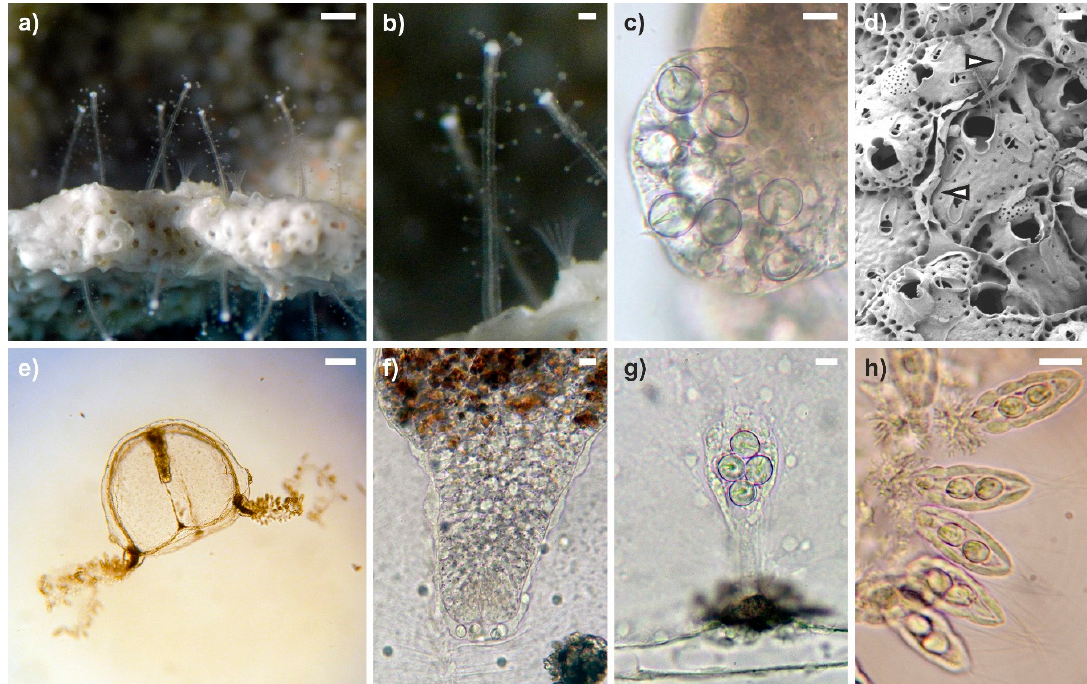
Figure 2. Zanclea cf. protecta . ( a ) Colony associated with Parasmittina cf. spondylicola ; ( b ) close-up of a polyp; ( c ) stenoteles in the capitula; ( d ) bryozoan skeletal lamina overgrowing the hydrorhiza (arrowheads); ( e ) newly released medusa; close-ups of ( f ) manubrium, ( g ) nematocyst pouch, and ( h ) cnidophores. Scale bars: ( a ) 0.5 mm; ( b,d,e ) 0,1 mm; ( c,f–h ) 10 μ m.